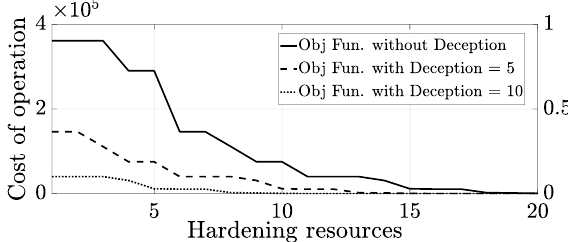
Figure 6. Objective function cost reduction with and without deception strategy.